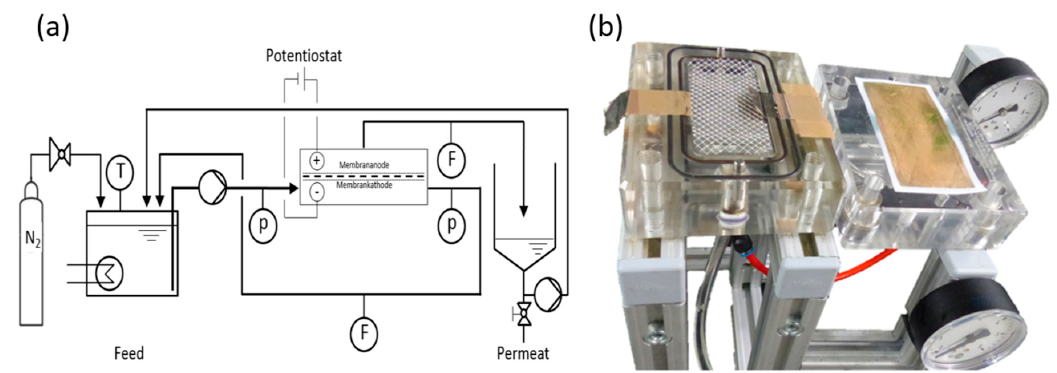
Figure 1. ( a ) Filtration setup; ( b ) Opened cross-flow cell (modified CF042) with titanium contacts, counter electrode, spacer and gold coated ultrafiltration (UF) membrane.